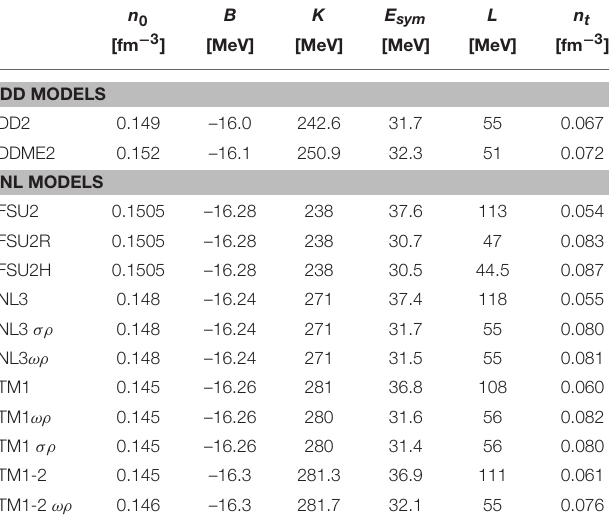
TABLE 1 | Nuclear matter properties of the models considered in this study: saturation density n 0 , binding energy B , incompressibility K , symmetry energy E sym , and its slope L , all defined at saturation density, and the crust-core transition density n t